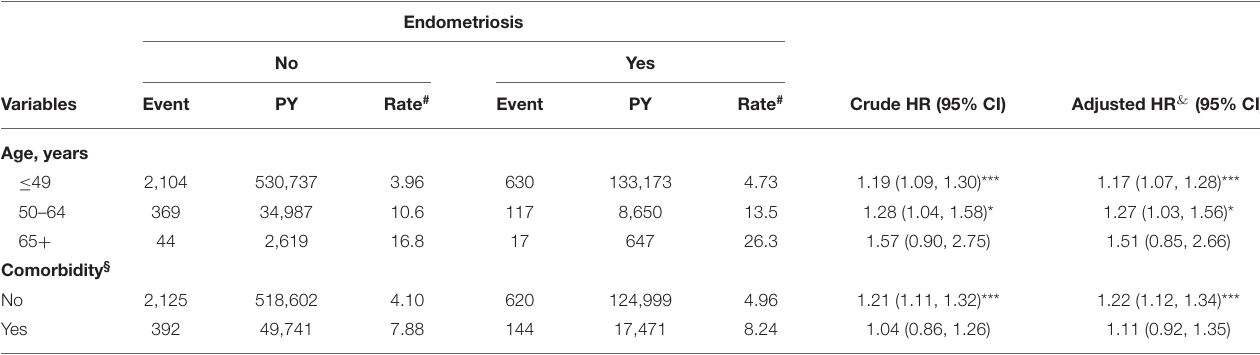
TABLE 3 | Incidence of herpes zoster by age, sex, and comorbidity and Cox model measured hazards ratio for patients with endometriosis compared those without endometriosis.